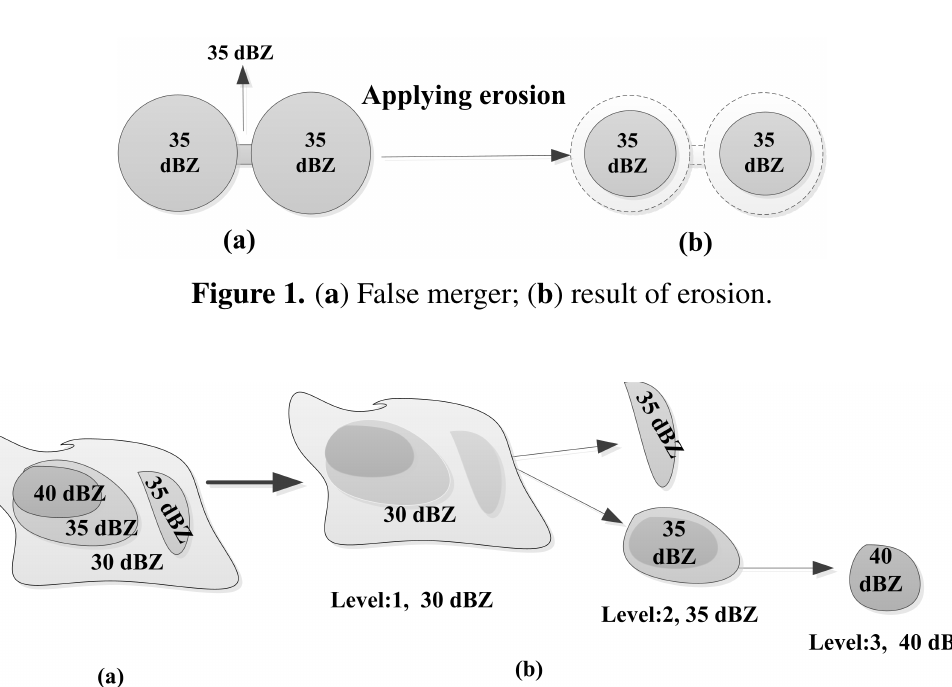
Figure 2. ( a ) Cluster of storms; ( b ) hierarchical form of storms after applying different levels of